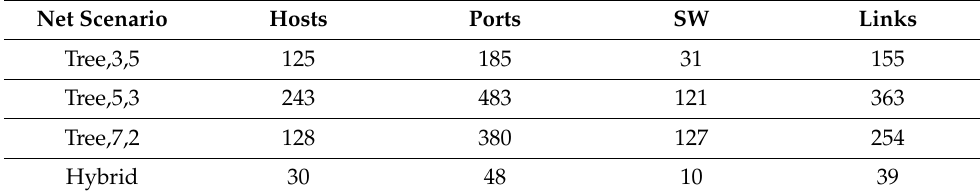
Table 6. Number of Switches, Hosts, Ports, and